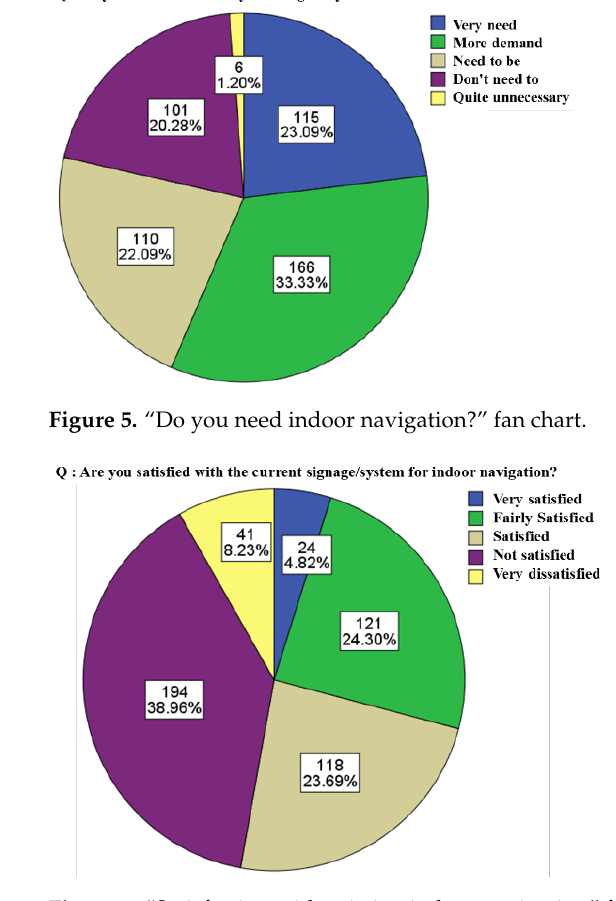
Figure 6. “Satisfaction with existing indoor navigation” fan chart.